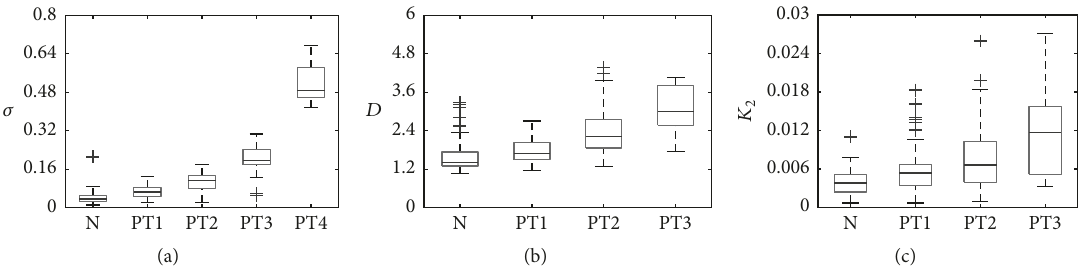
Figure 3: Invariant estimation box plot: (a) noise level, (b) correlation dimension, and (c) correlation entropy. Normal (N), pathological type 1 (PT 1 ), pathological type 2 (PT 2 ), pathological type 3 (PT 3 ), and pathological type 4 (PT 4 ) voices.